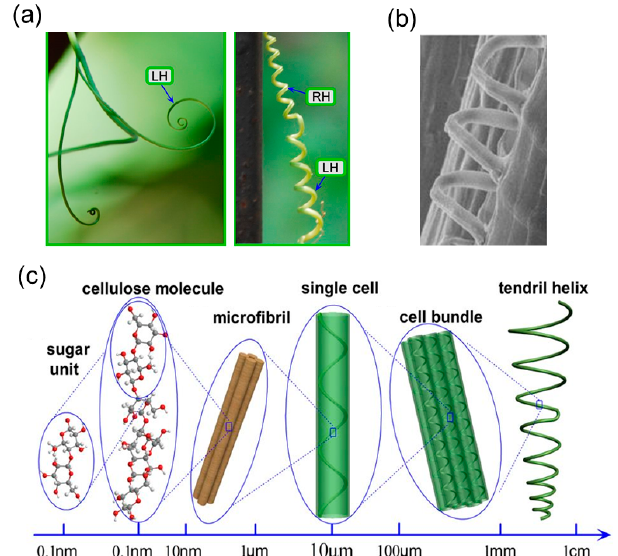
Figure 11. Coiling mechanism of Towel Gourd tendrils. ( a ) Towel Gourd tendril coils into a spiral shape with left-handedness before it touches a support (left) and forms a perversion connecting the right-handed and left-handed sections once it attaches to a support (right). ‘LH’ and ‘RH’ represent left-handed and right-handed, respectively; ( b ) Image of helical cellulose fibril inside cell’s matrix under scanning electron microscope; ( c ) Hierarchical chirality inside Towel Gourd tendril from the molecular level to the macroscopic shape. ( a – c ) are from [12], reprinted with permission from Nature Publishing Group.